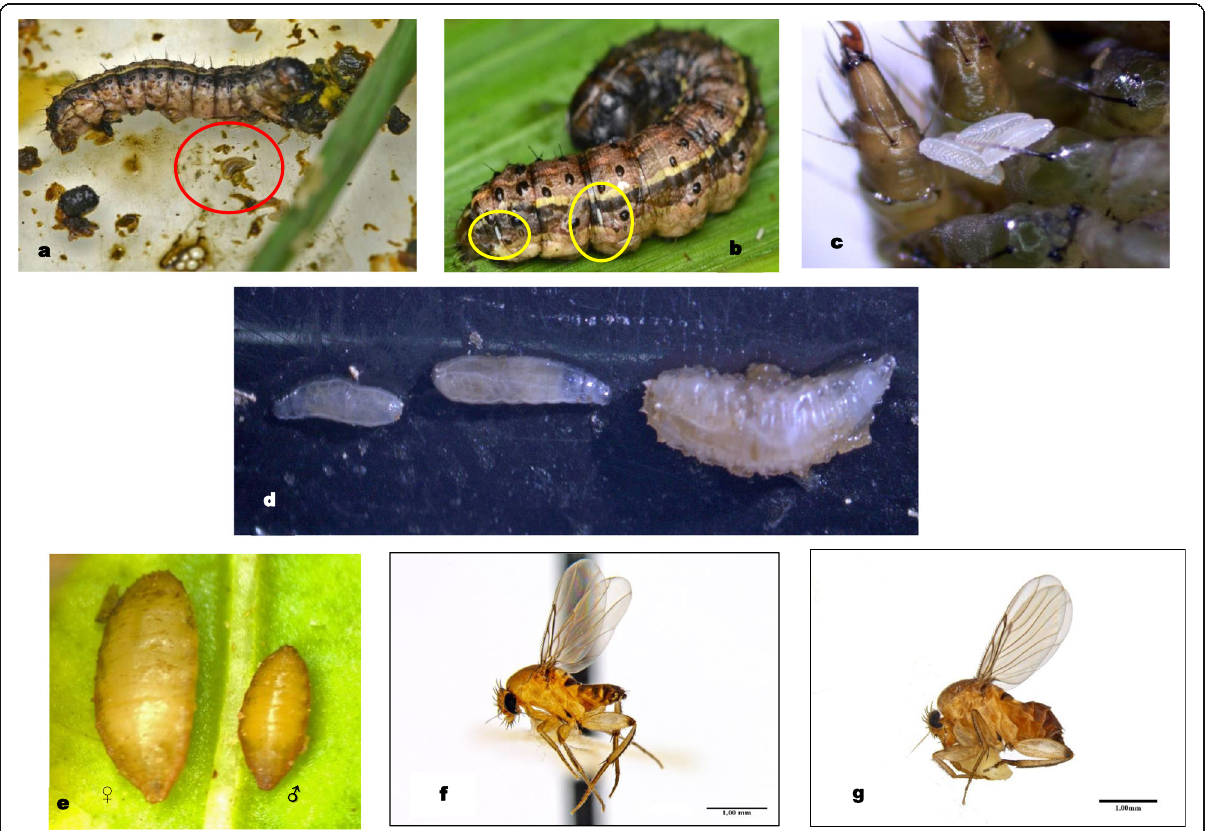
Fig. 1 Developmental stages of Megaselia scalaris . a Maggots emerging out of infested larva. b Eggs laid on later instar larva. c Eggs laid on pre- pupa. d Three instars of maggot. e Female and male pupa. f Adult male. g Adult